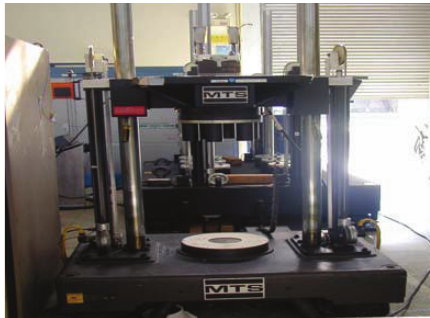
Figure 5: The setup of the free-fall shock machine.